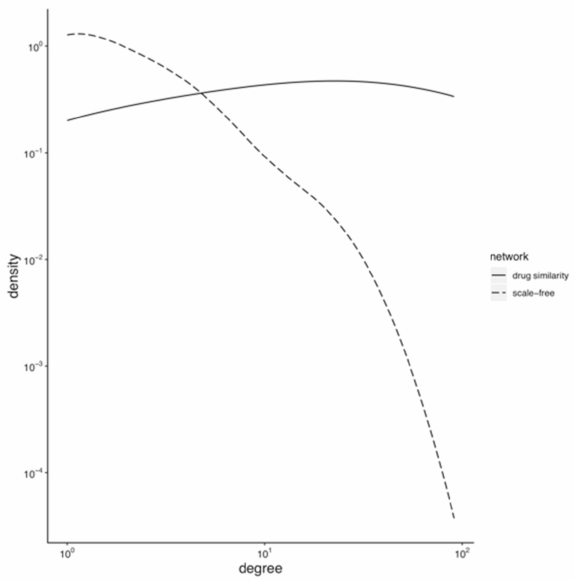
Figure 3. Degree distribution of the drug similarity network. The degree distribution of the drug similarity network (full line) is compared with a scale-free model of the same size (dashed line).